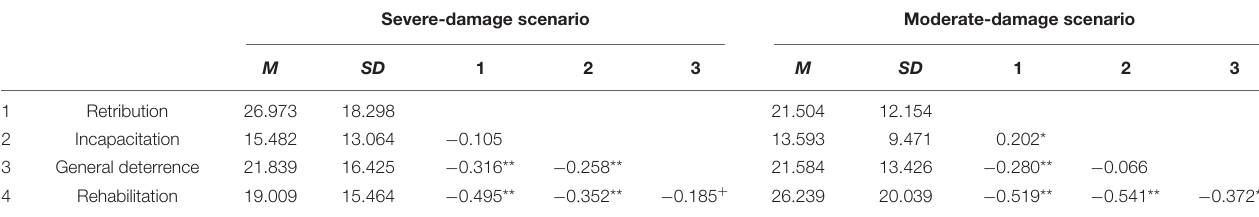
TABLE 1 | Bivariate correlations of justifications.